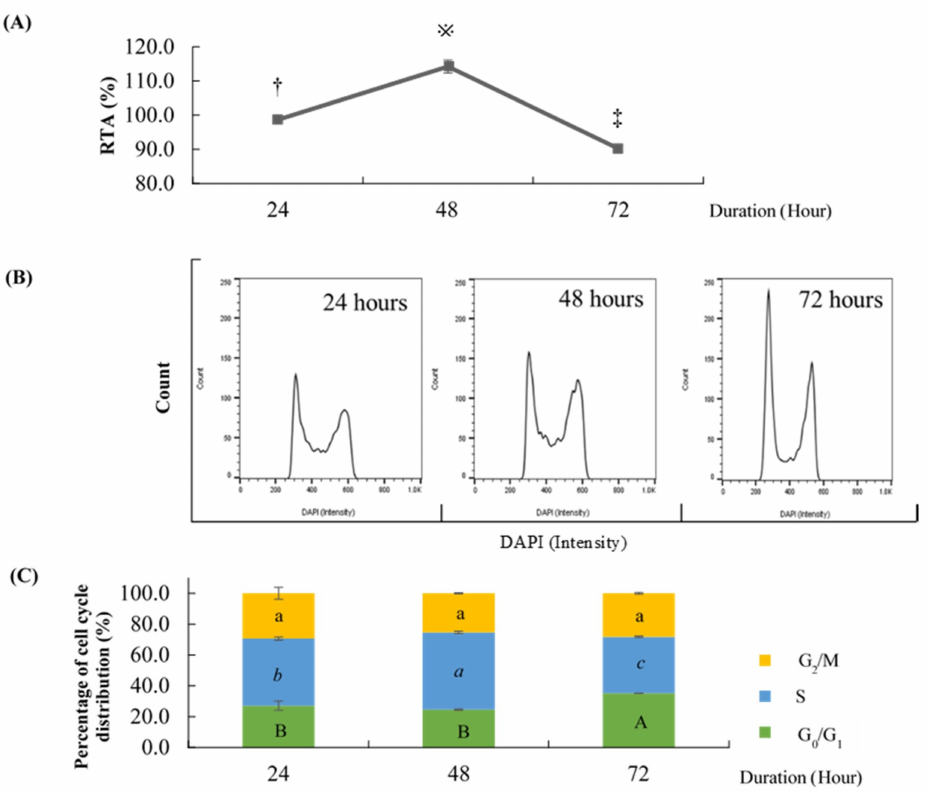
Figure 1. Effects of different time points on relative telomerase activity (RTA) and percentage of HCT 116 cell cycle distribution. ( A ) Telomerase activity of HCT 116 harvested at different time points relative to telomerase-positive control (HEK293). Values are mean ± standard error of triplicate. Mean with different symbols (†, ※ , or ‡) differ significantly at p < 0.001. ( B ) Representative cell cycle histogram of HCT 116 harvested at different time points stained with DAPI and analyzed by flow cytometry. ( C ) Percentage of cell cycle distribution of HCT 116 at different time points analyzed by FlowJo version 10. Values are mean ± standard error of triplicate. Mean with different letters differ significantly at p < 0.05 (subject to different cell cycle phases). G: Growth, S: Synthesis, M: Mitosis.